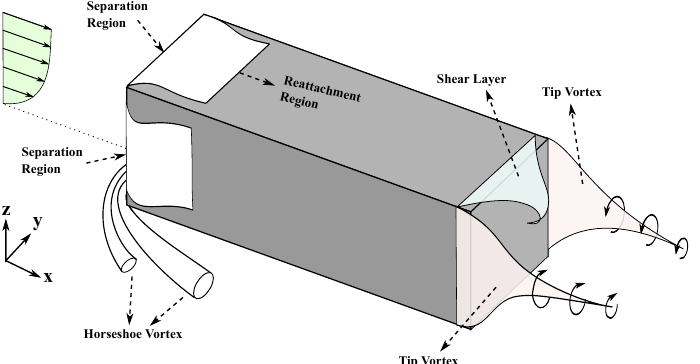
Figure 27. The skeleton model of the steady wake formed behind a long rectangular